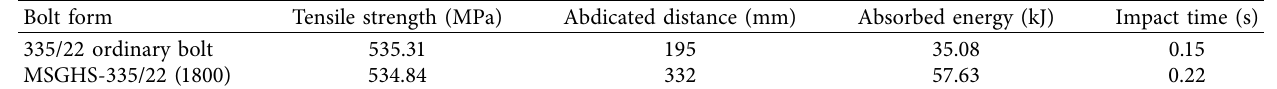
Table 4: Impact loading of ordinary and energy-absorbing anti-shock